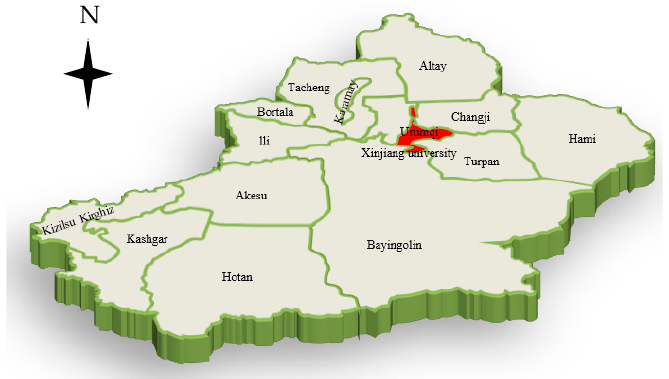
Figure 1. Locations of the sampling sites in Urumqi.